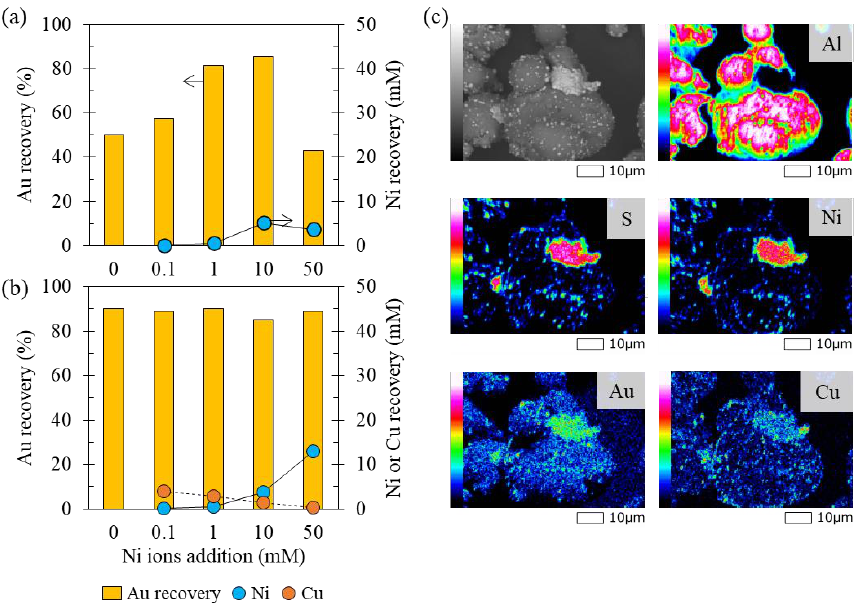
Figure 6. Recovery of gold ions from ammonium thiosulfate solution with varying additions of Ni ion concentrations from 0 to 50 mM ( a ) without and ( b ) with 10 mM of Cu ions in the solution, and ( c ) SEM photomicrographs with corresponding elemental maps of the residue.